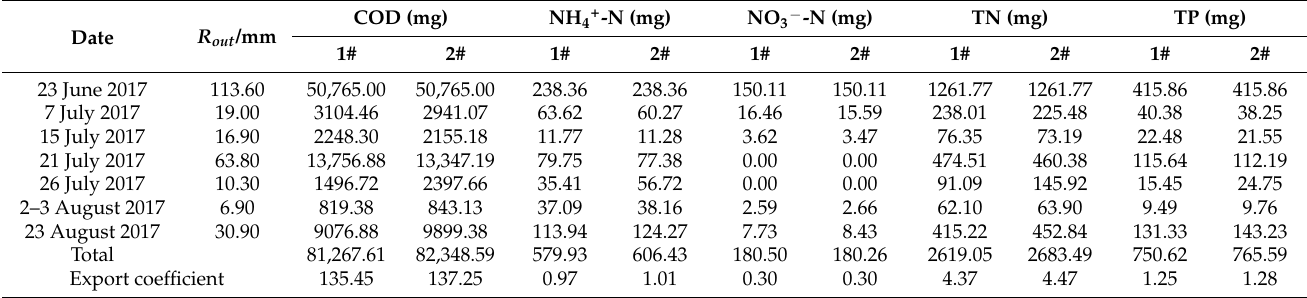
Table 3. Loads of different forms of COD, TN, TP, NH 4+ -N, and NO 3 − -N based on points 1# and 2# in the paddy